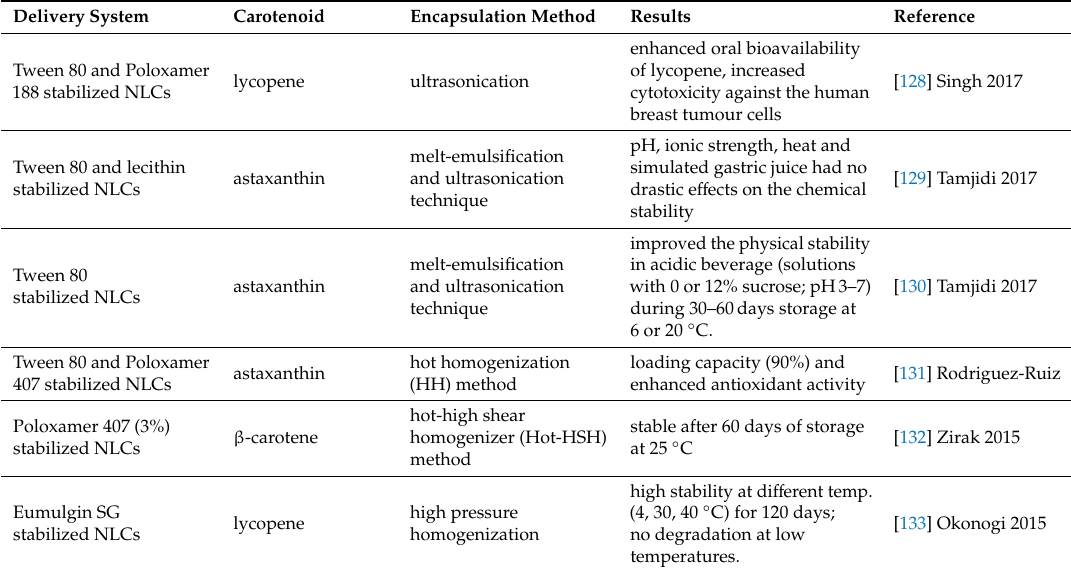
Table 6. Nanostructured lipid carriers (NLCs) as delivery system for carotenoid